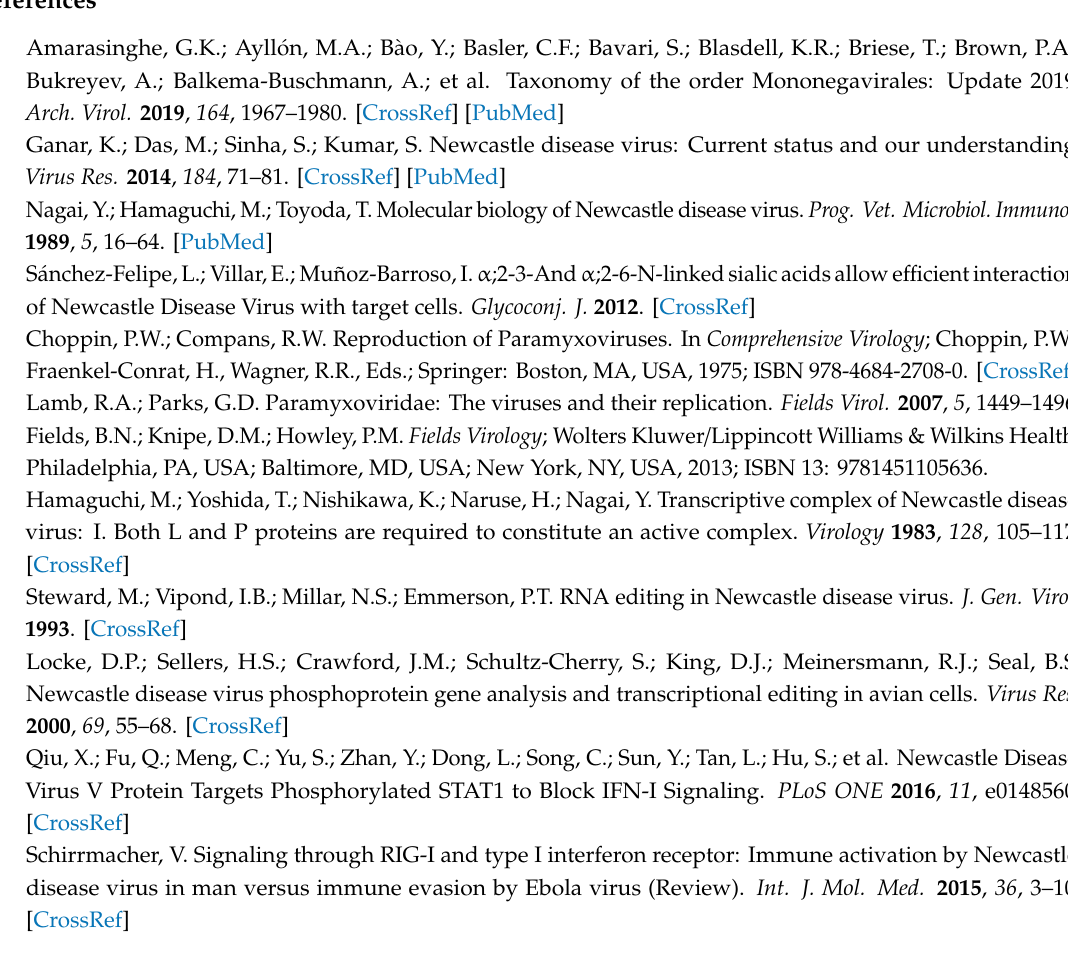
Table S1: information about samples, Table S2: L / P coverage ratio as upper bound on the contribution of genomic RNA to the reads, for each sample in our datasets, Table S3: p-values of Student’s t-test for di ff erences in fraction of P mRNA, Table S4: combined linear model for log10(mRNA fraction) as a function of experiments and length of insertion, Figure S1: distributions of inferred values of p , p from the weighted linear model presented in the r s Main Text, assuming independent Gaussian uncertainties for each term of the